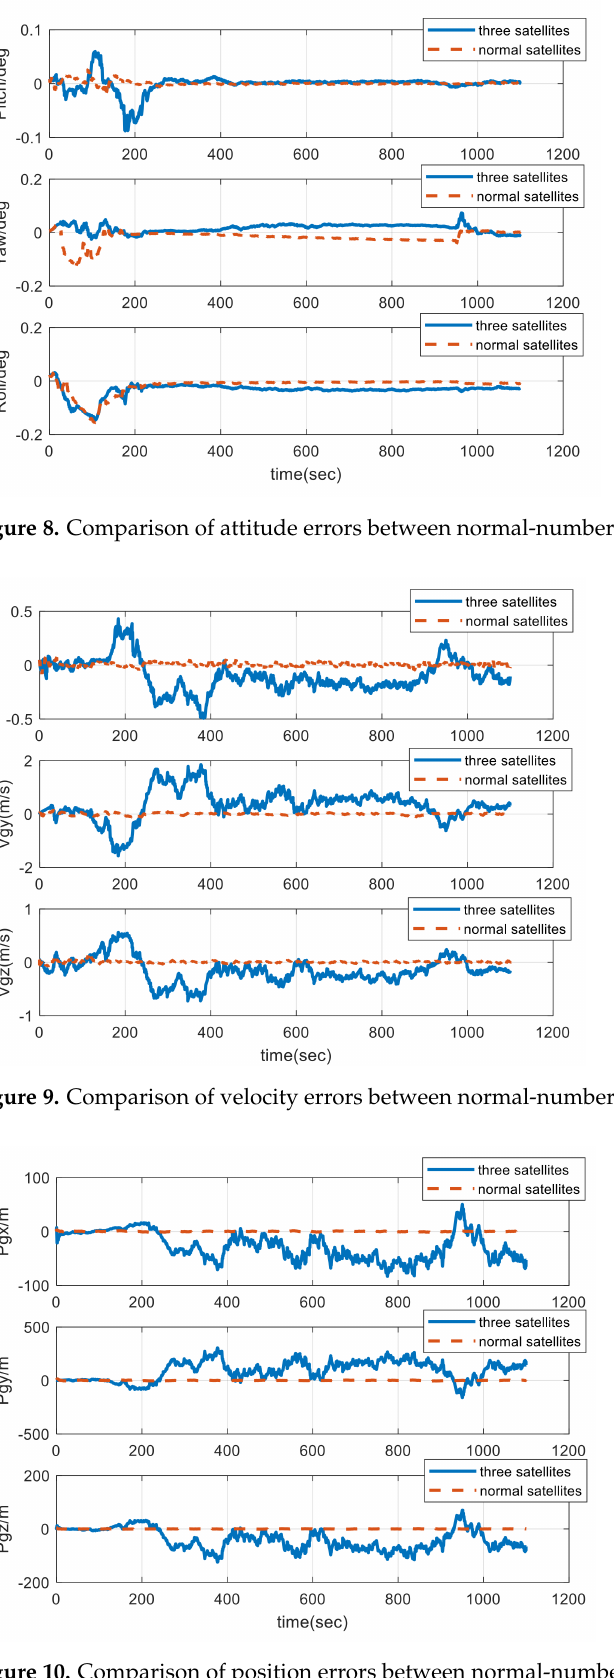
Figure 10. Comparison of position errors between normal-number satellites and three